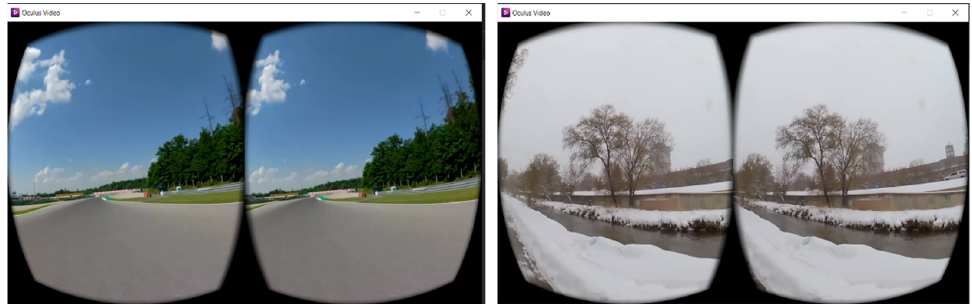
Table 1. The differences between the contents of both visual conditions.